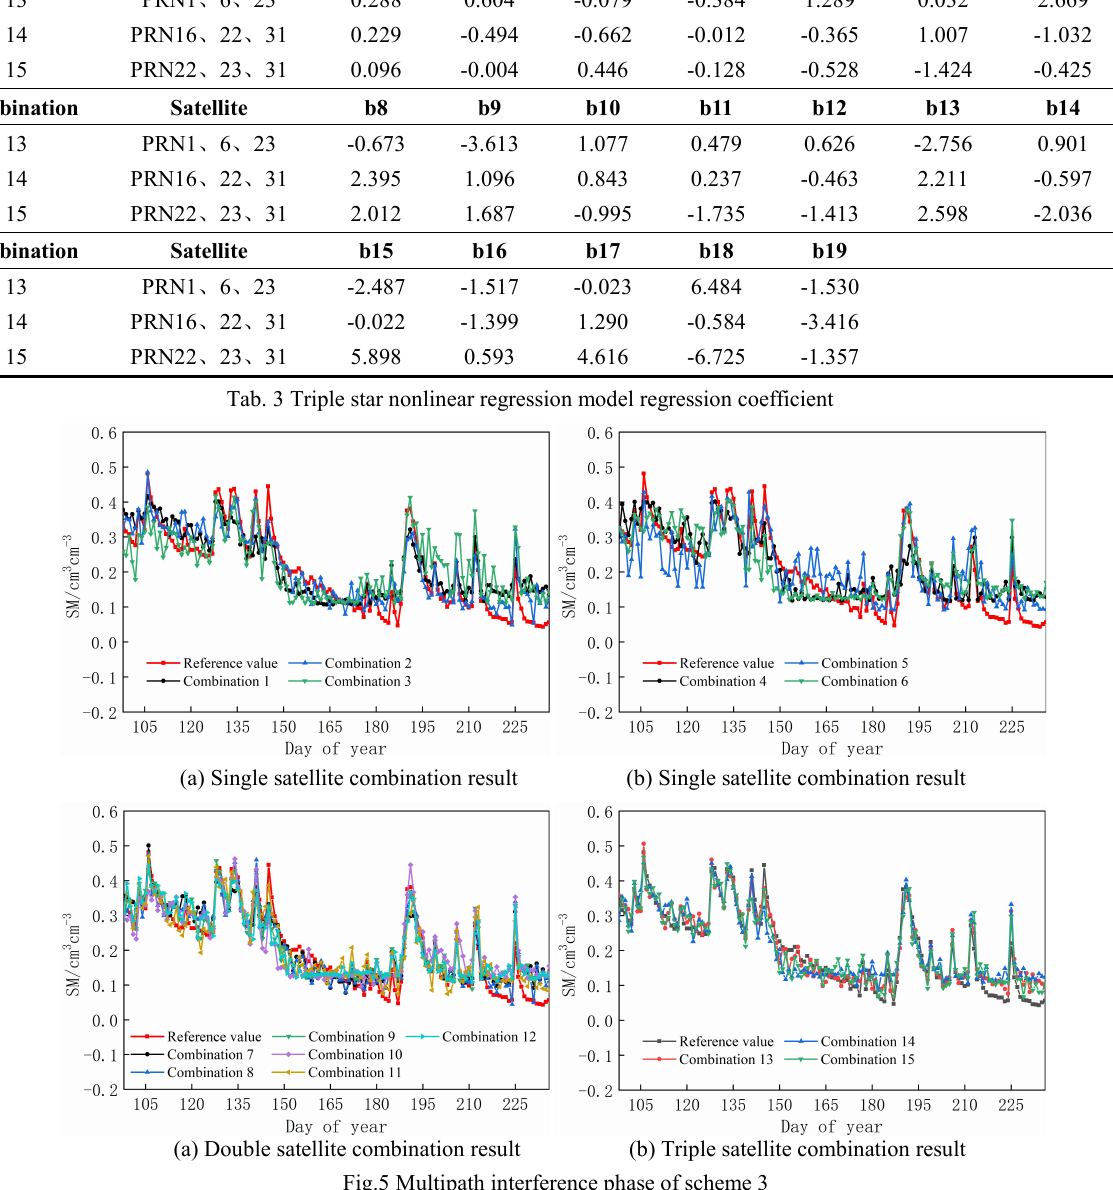
Fig.5 Multipath interference phase of scheme